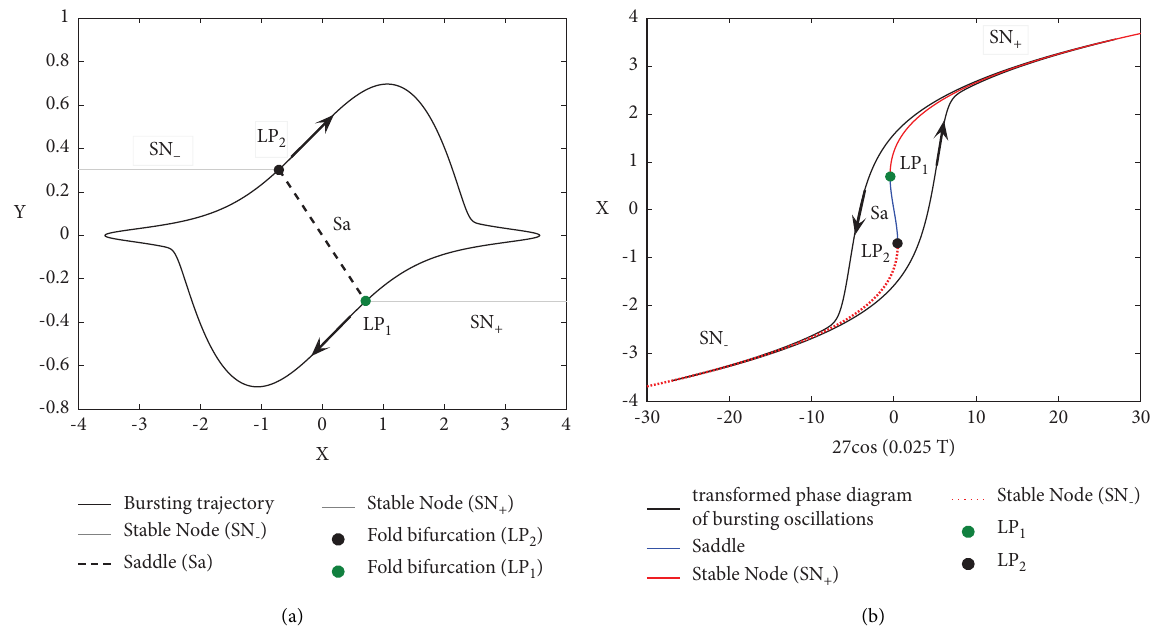
Figure 13: (a) Overlay of the phase portrait in the plane ( X − Y ) obtained for parameters of Figure 6(a) with the equilibrium points of the system defned in Figure 11(b) and (b) transformed phase diagram of bursting trajectory for ξ � 2 . 5.